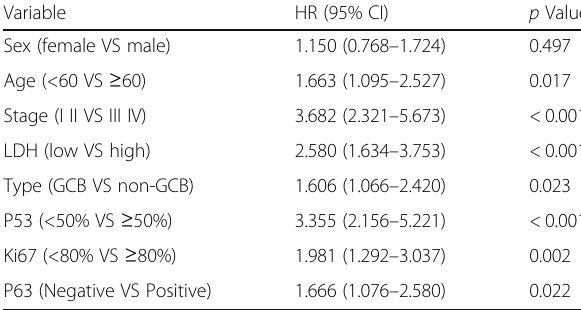
Table 2 Multivariate analysis for overall